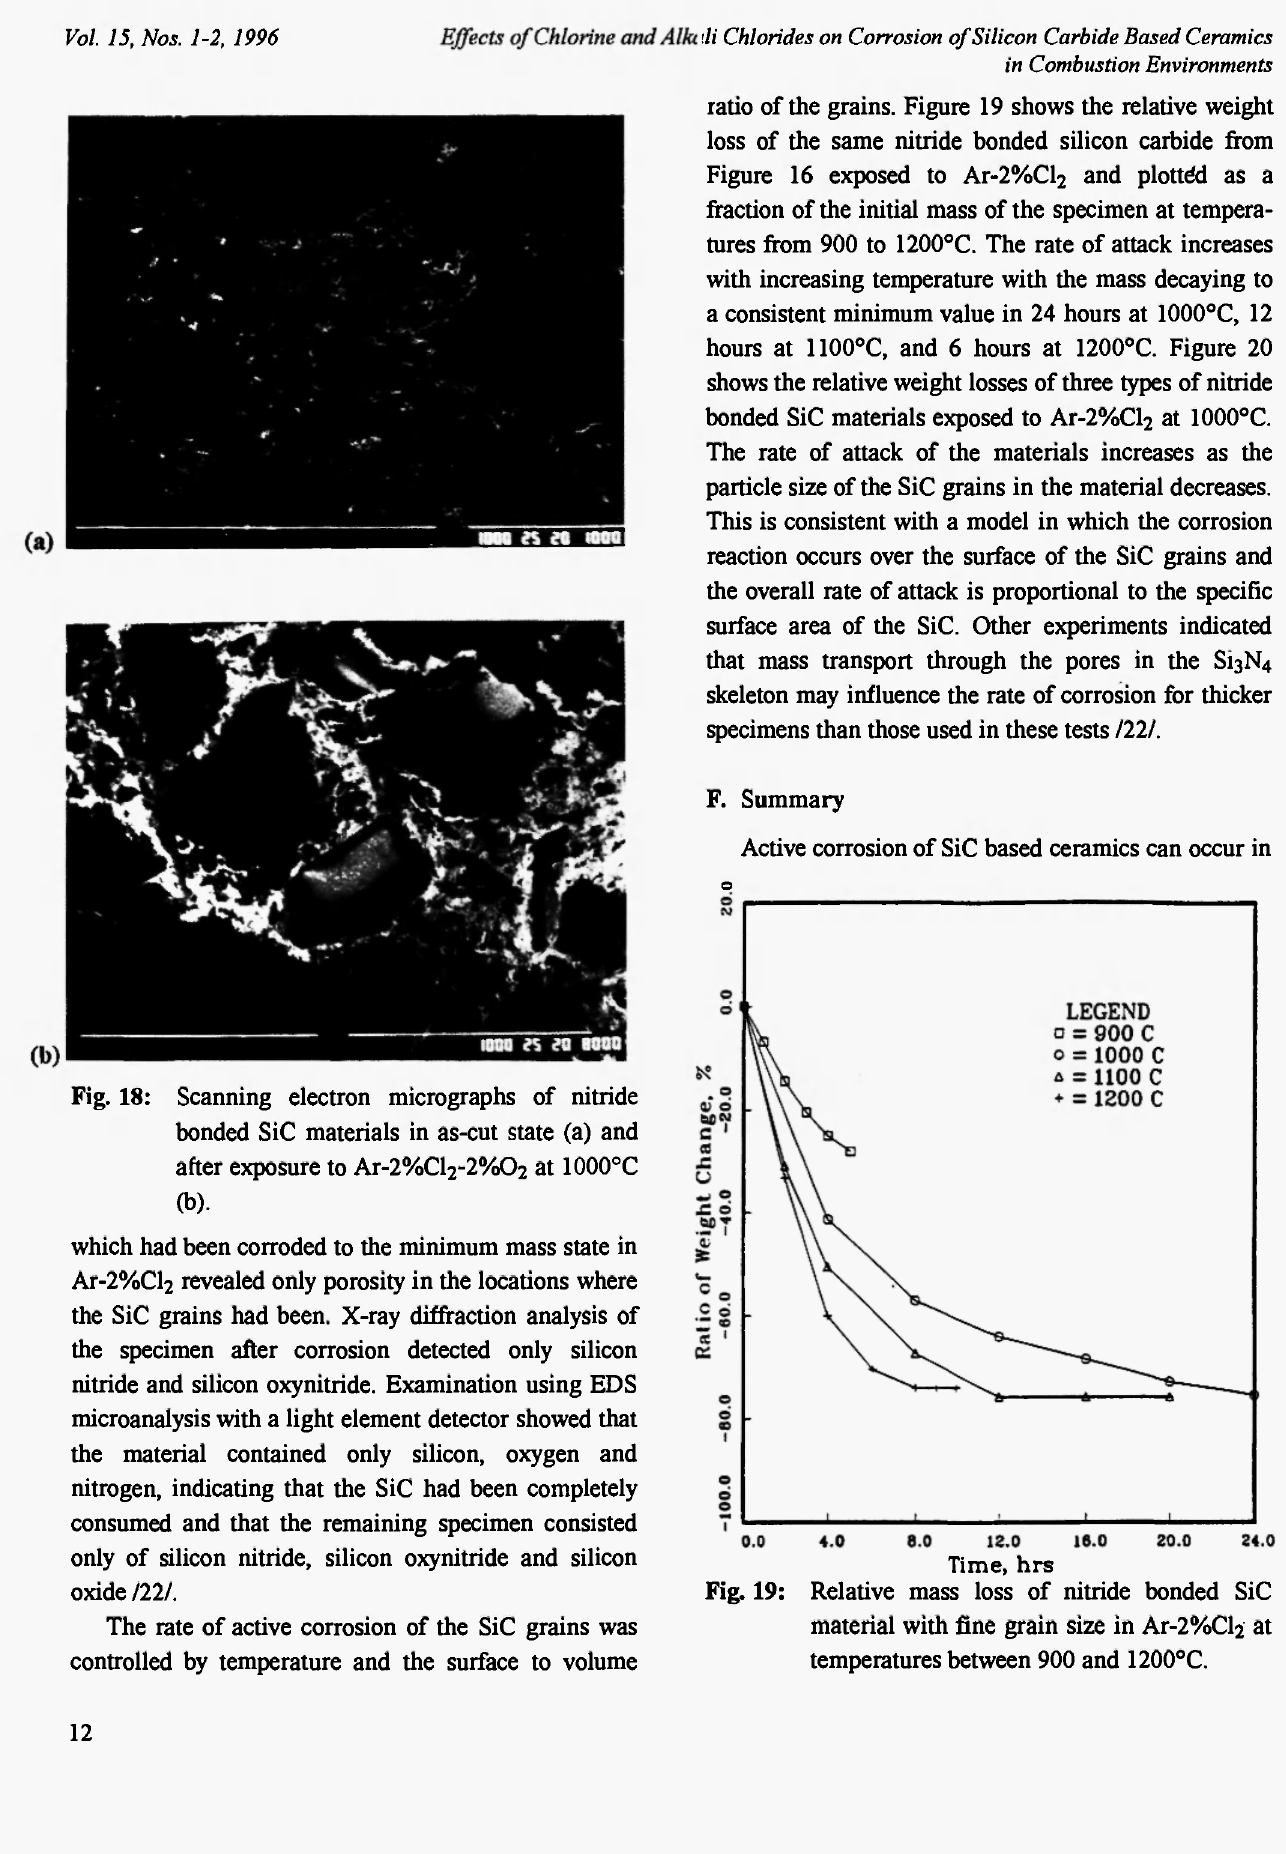
Fig. 18: Scanning electron micrographs of nitride bonded SiC materials in as-cut state (a) and after exposure to Ar-2%Cl (b).